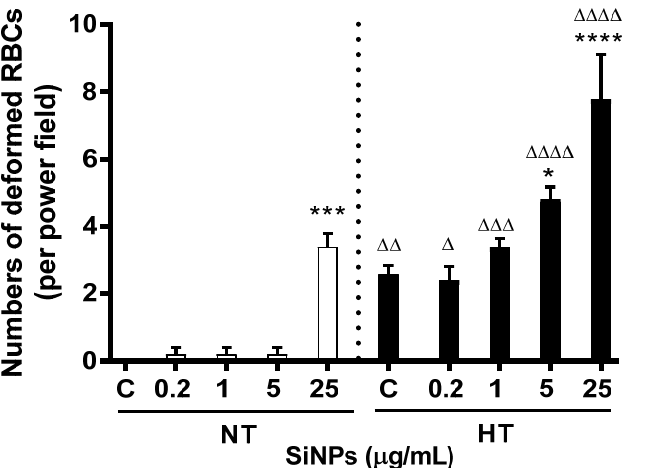
Figure 3. Numbers of deformed red blood cells (RBCs) (per power field, ×11,100) of normotensive (NT) and hypertensive HT) rats after treatment with various concentrations ( μ g/mL) of silica nano ‐ particles (SiNPs). Data are mean ± SEM ( n = 5 in each group). Statistical analysis by one ‐ way analysis of variance (ANOVA) followed by the Holm ‐ Sidak multiple comparisons test. * p < 0.05, *** p < 0.001, **** p < 0.0001 vs. respective control and Δ p < 0.05, ΔΔ p < 0.01, ΔΔΔ p < 0.001, ΔΔΔΔ p < 0.0001 vs. respective concentration in NT group.